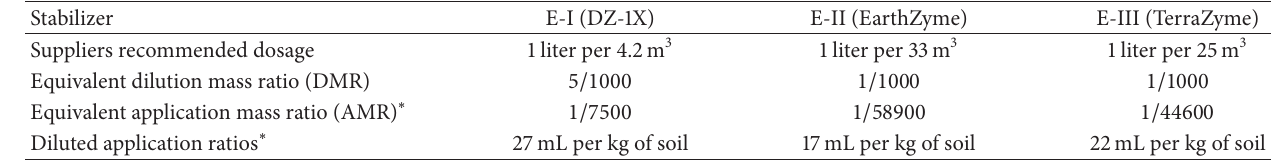
Table 2: Recommended dosages, dilution ratios, and diluted application ratios of